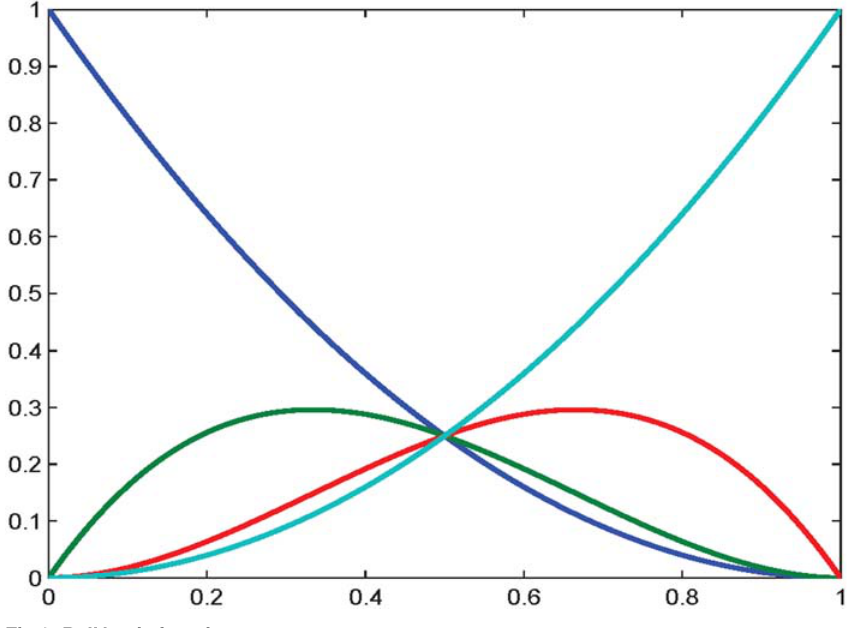
Fig 1. Ball basis